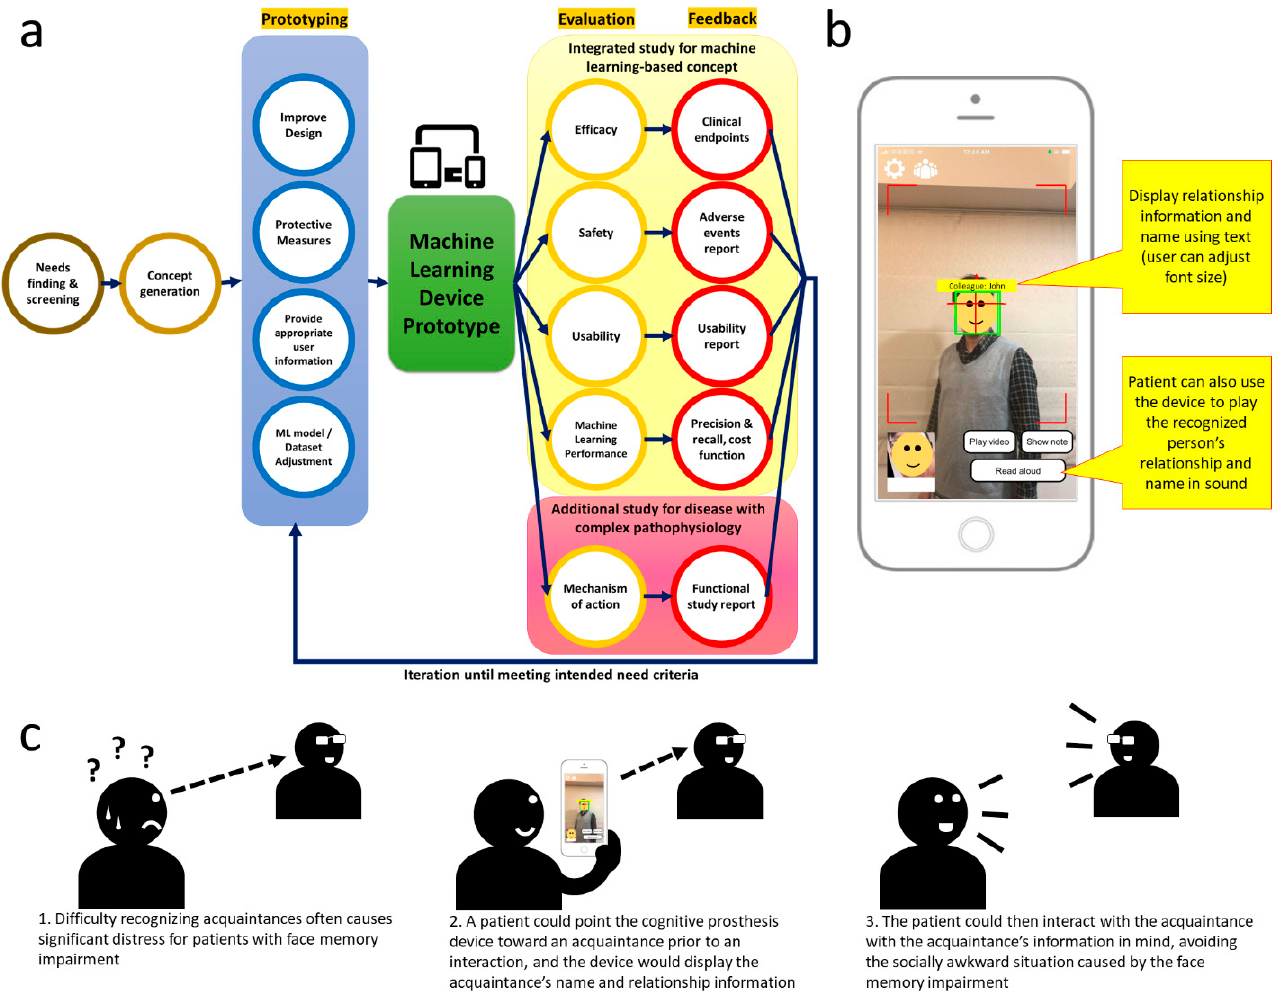
Figure 1. Concept exploration and testing for machine-learning-based concept and disease with complex pathophysiology ( a ), and the cognitive prosthesis for facial recognition device prototype in the present study ( b ). Triptech storyboard for the cognitive prosthesis device is also shown ( c ).